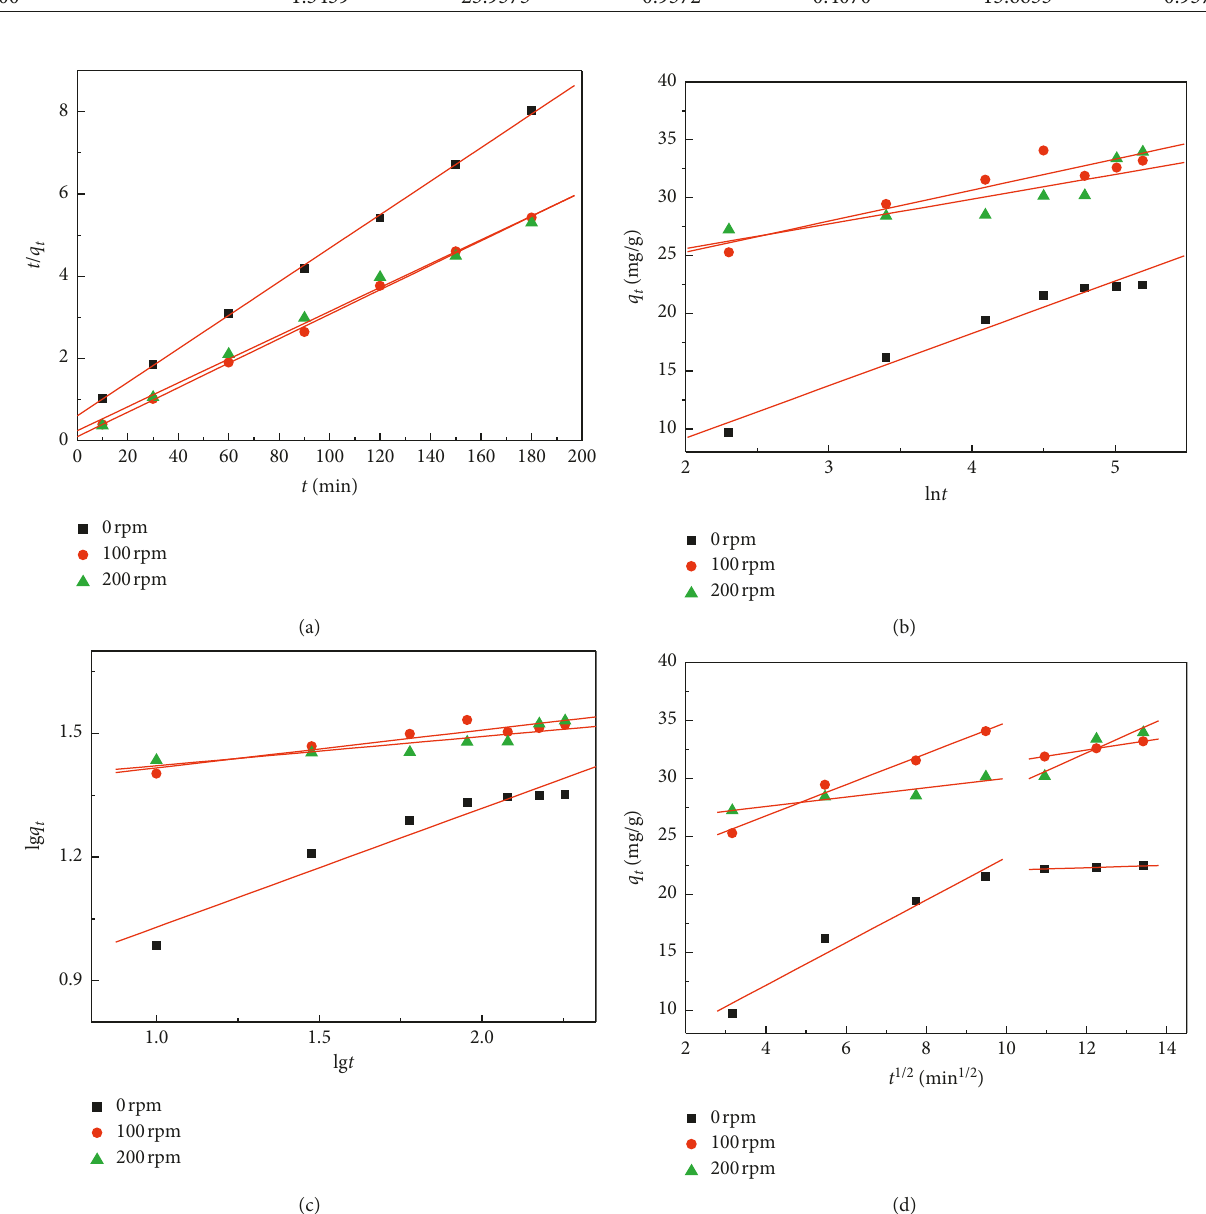
Figure 7: Fitting curves of adsorption kinetic equations: (a) pseudo-second-order kinetic model; (b) Elovich model; (c) Bangham model; (d) intraparticle diffusion